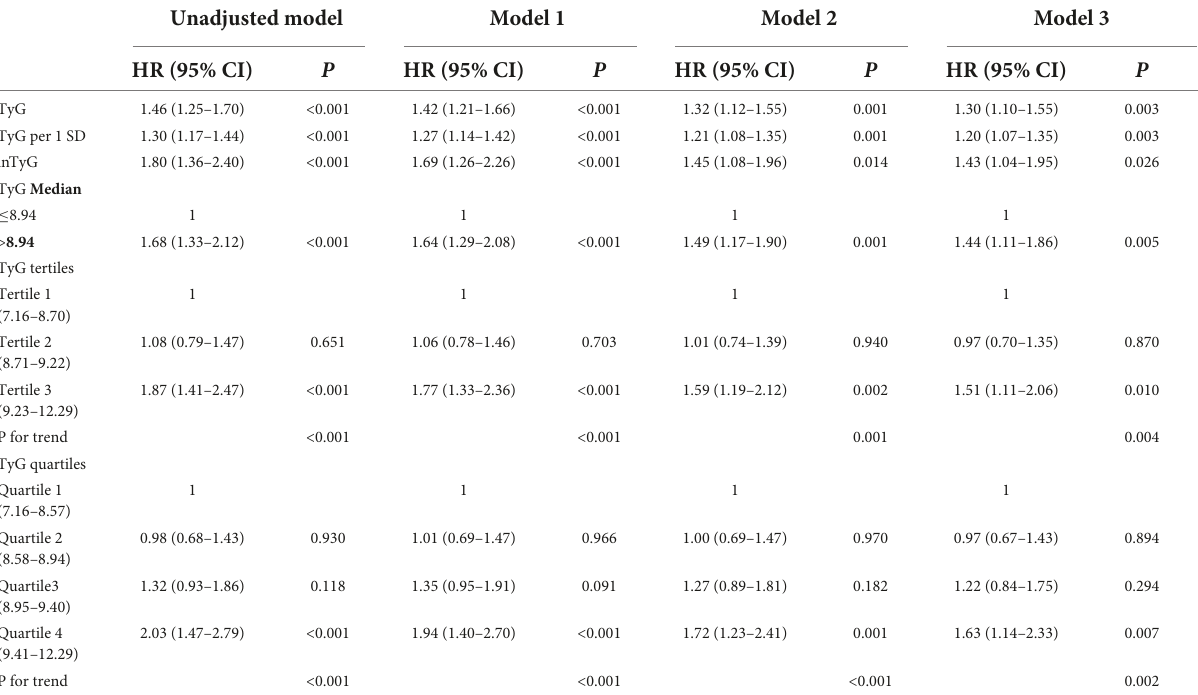
TABLE 2 Association between TyG and CKD.